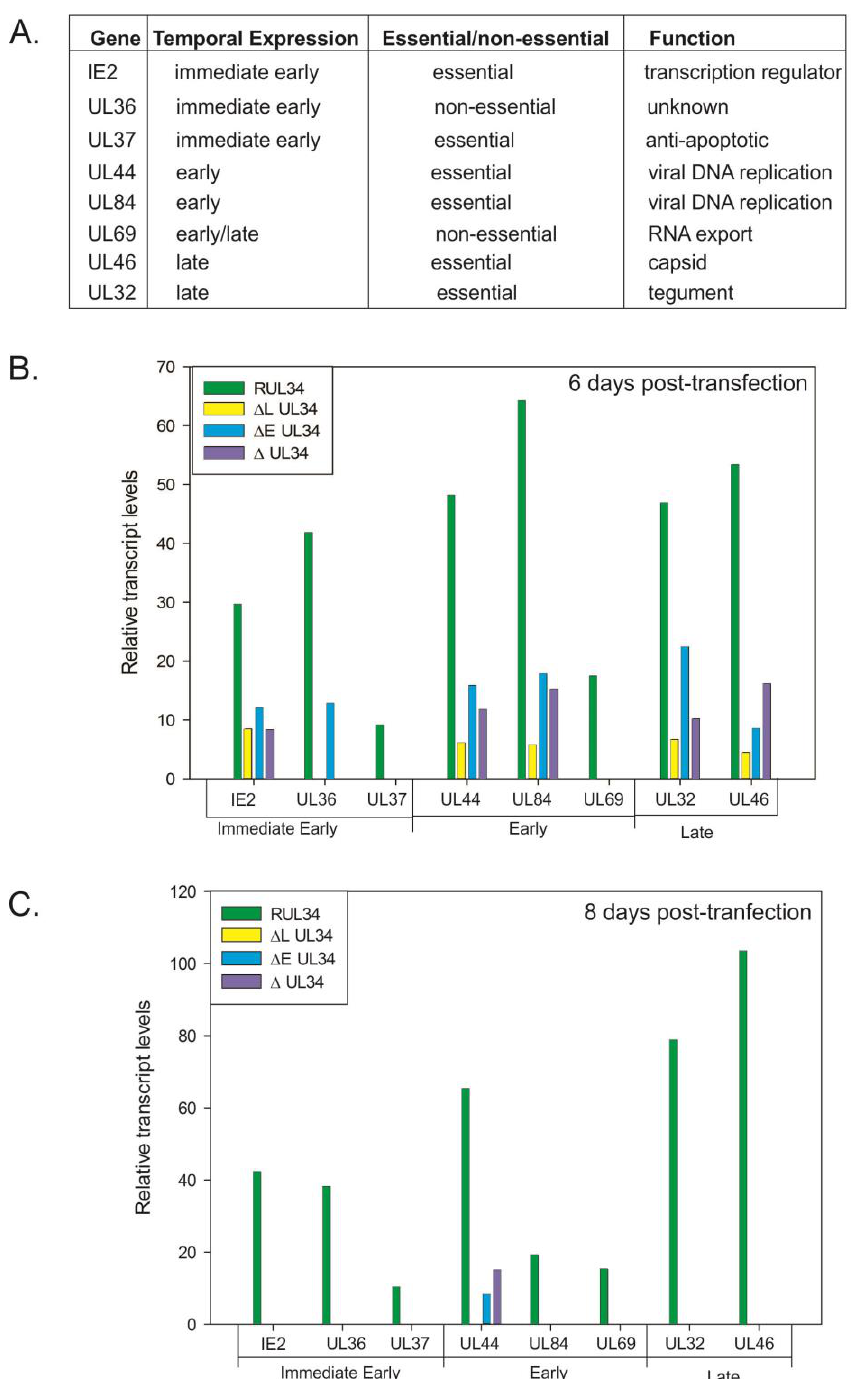
Figure 1. ( A ) List of genes assayed for expression in cells receiving the recombinant UL34 human cytomegalovirus (HCMV) bacterial artificial chromosome (BACs). ( B ) and ( C ) Relative transcript levels for the indicated genes at 6 and 8 days post-transfection. RT-PCR was used to amplify the transcripts for each of the listed genes along with the cellular gene, glyceraldehyde phosphate dehydrogenase (GAPDH). The amplification products were quantified; viral gene levels were normalized to the level of GAPDH amplimers obtained for each of the samples. RUL34 is the UL34 rescued HCMV BAC,  L UL34 has the initiation codon for the late protein mutated,  E UL34 has the initiation codon for the early protein mutated and  UL34 has the entire UL34 open reading frame